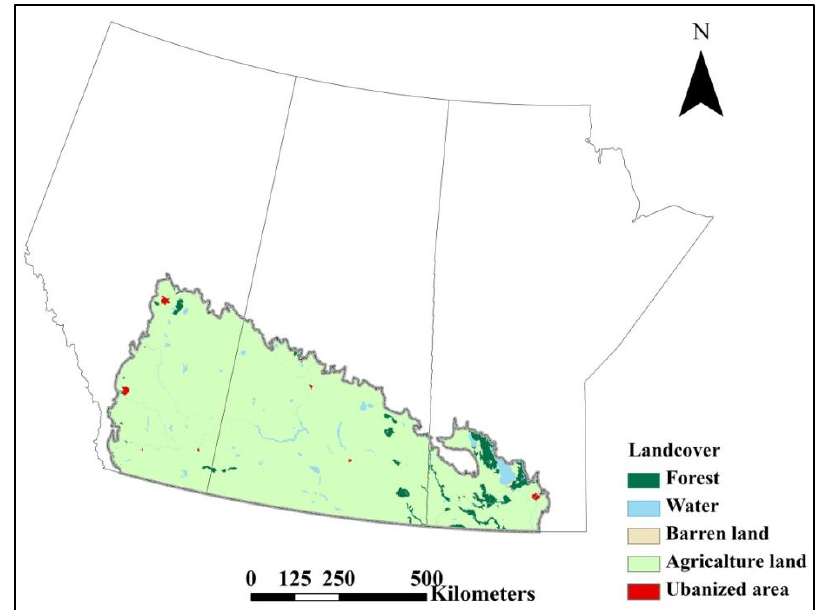
Figure 3. Distribution of land cover types in the Canadian